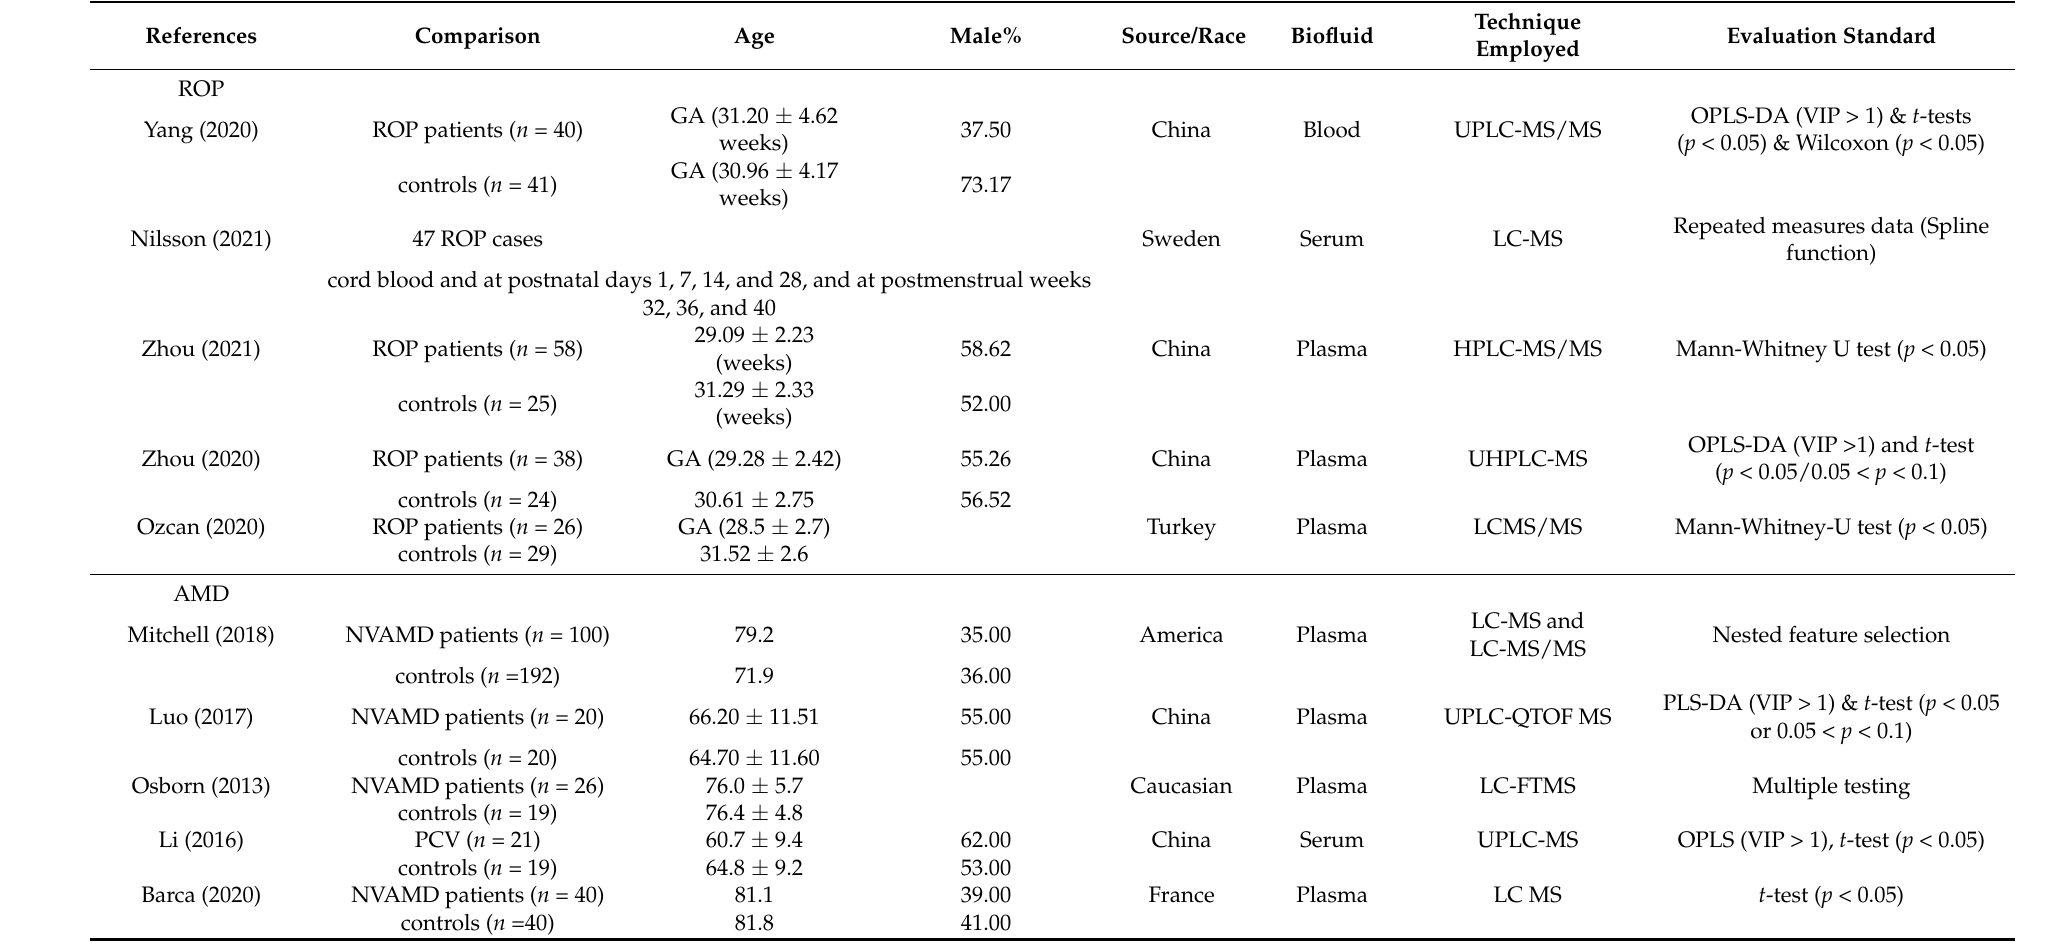
Table 1. Characterization of metabolomics studies of retinal neovascularization